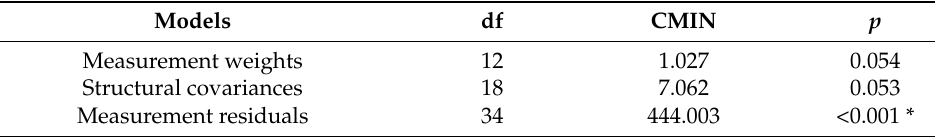
Table 4. Multi-Group Analysis.